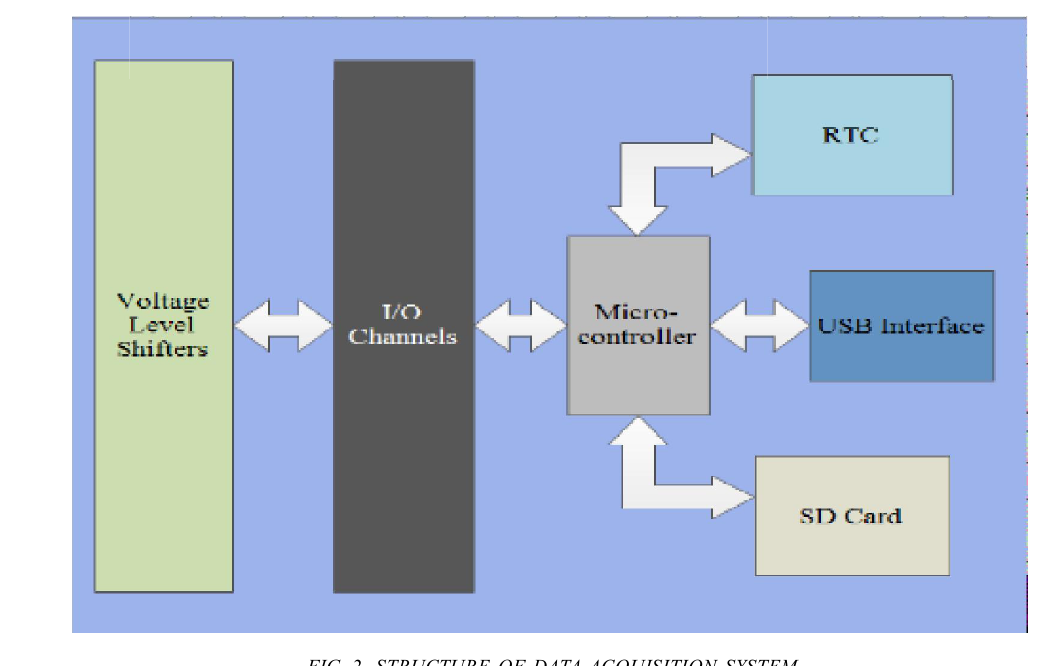
FIG. 2. STRUCTURE OF DATA ACQUISITION